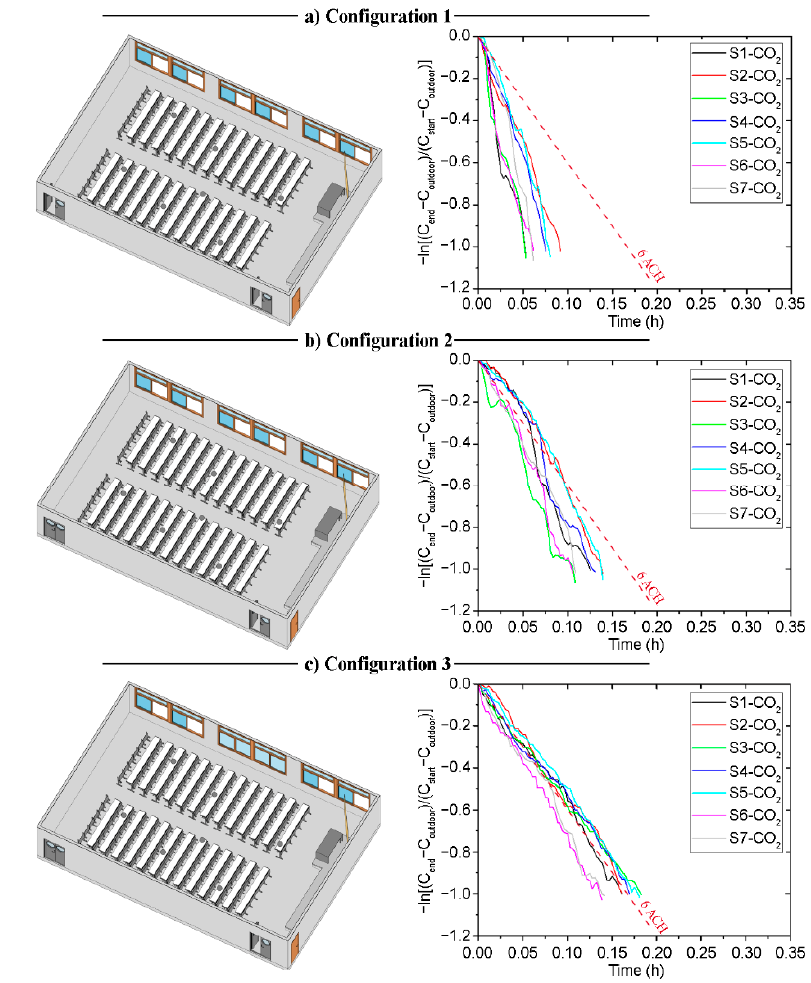
Figure 12. Configuration schemes and decay curves in Classroom B2-A2. ; ( a ) Configuration 1; ( b ) Configuration 2; ( c ) Configuration 3.